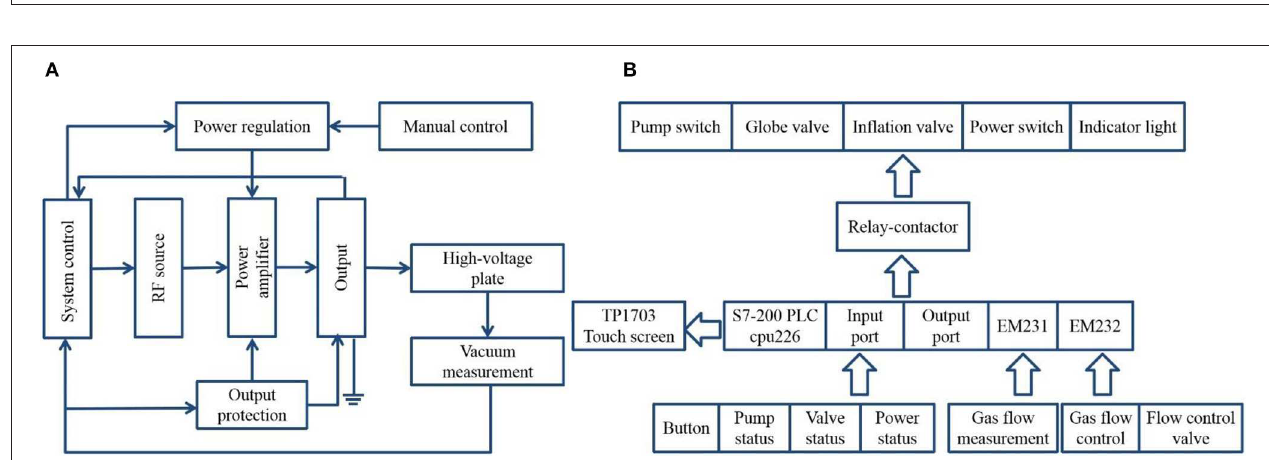
FIGURE 1 | Schemes of instrument and analytical principle for in situ measuring FLAS. (A) Components of the instrument. (B) Schematic diagram showing the layer is composed of n sublay.